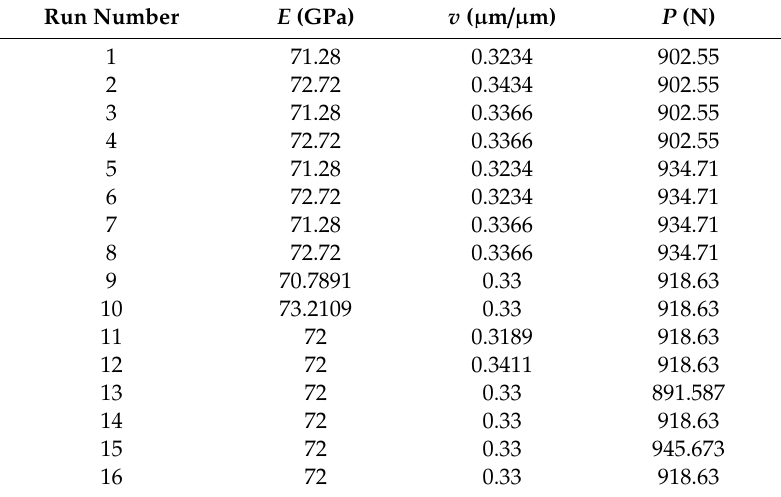
Table 4. Experimental design based on the materials properties and applied load.